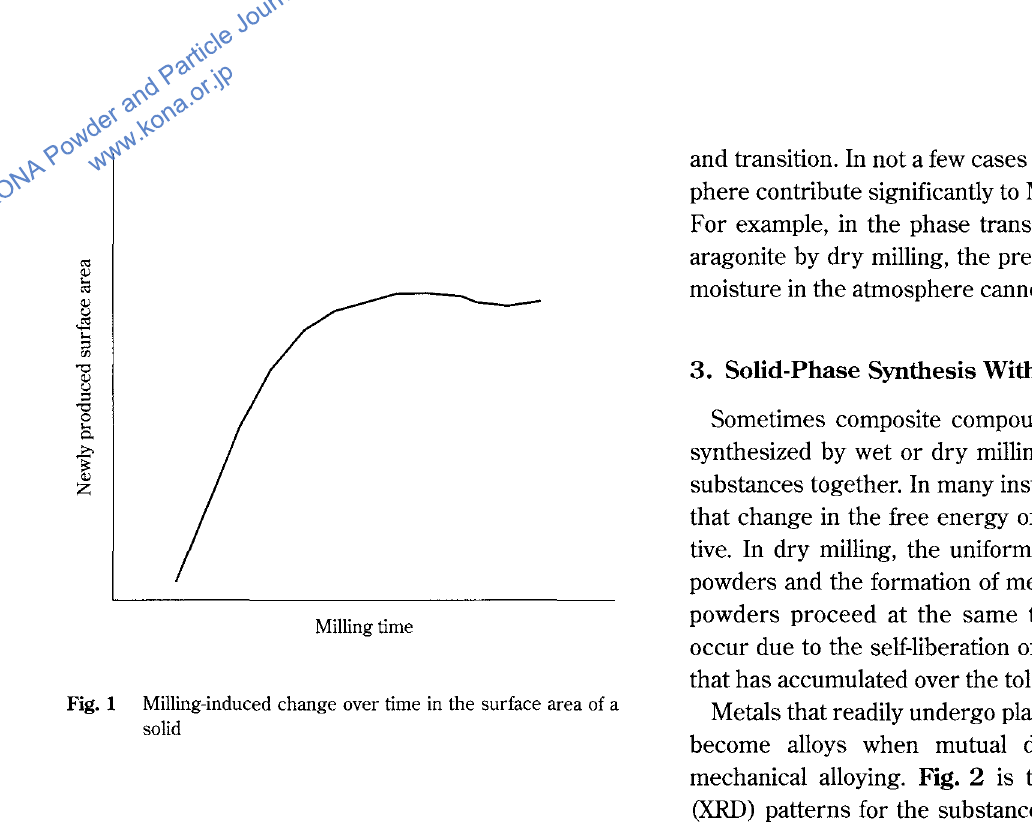
Milling-induced change over time in the surface area of a solid